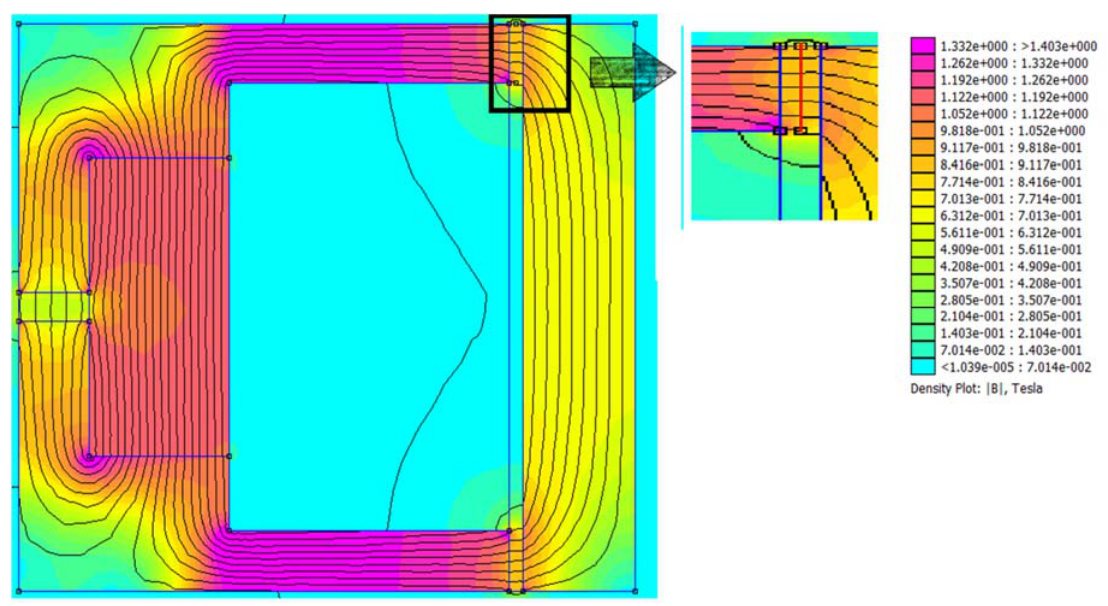
Fig. 7. The NC MR valve magnetic flux intensity result.